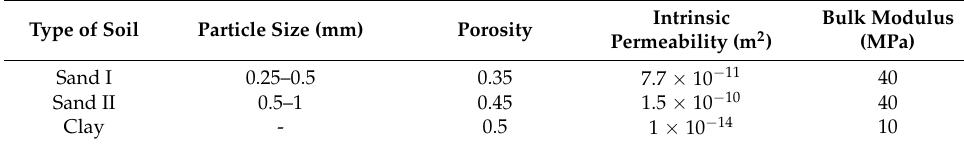
Table 1. Properties of clay and sand used in the simulation.